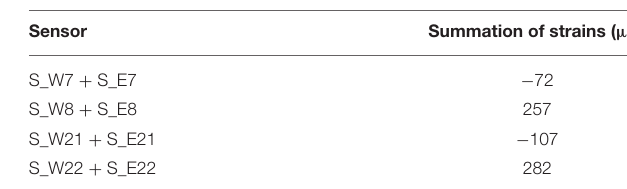
TABLE 4 | Baseline response summation of girder